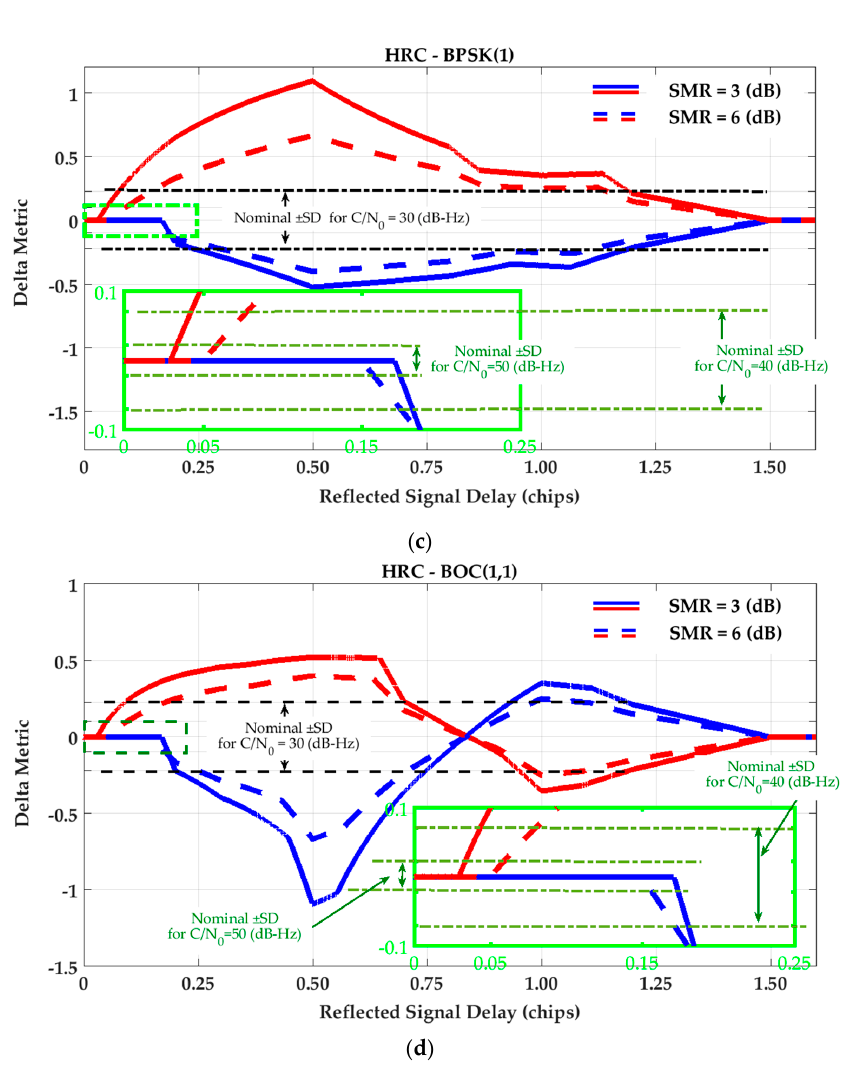
Figure 3. SQM variation envelopes of Delta metric for ( a ) Narrow Correlator (NC) tracking strategy and BPSK(1) signaling; ( b ) Narrow Correlator (NC) tracking strategy and BOC(1,1) signaling; ( c ) High Resolution Correlator (HRC) strategy and BPSK(1) signaling; ( d ) High Resolution Correlator (HRC) strategy and BOC(1,1) signaling.